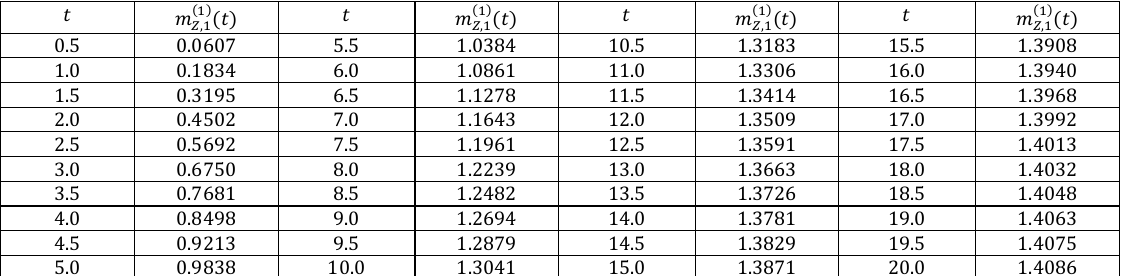
Table 1. Environment level 1 dependent growth of maligant cells (One mutation)